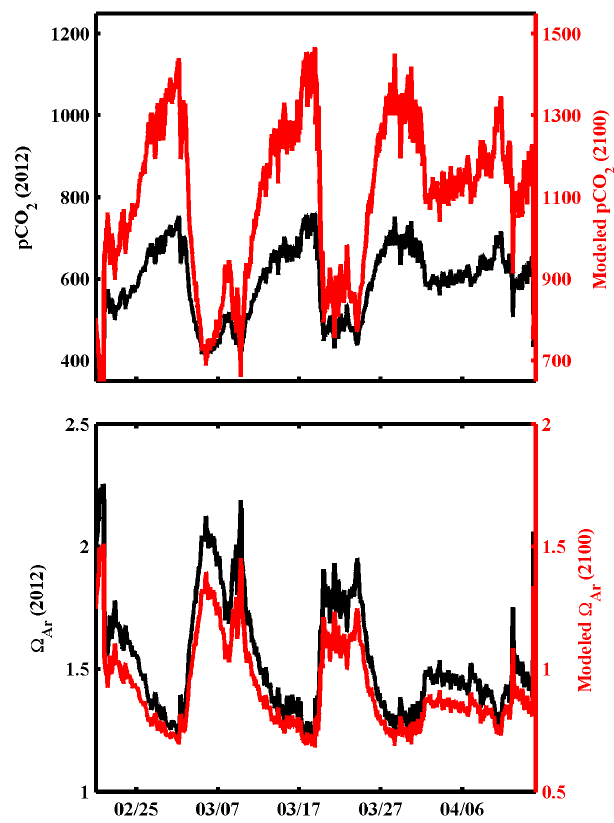
Figure 10. Observed (black) and modeled (red) p CO 2 (top) and (cid:127) Ar (bottom) at the La Jolla kelp forest (17m). Modeled values correspond to projected values in 2100 using the IPCC RCP6.0 sce- nario. Note that the range, but not the absolute values, of the vertical axes for each figure is the